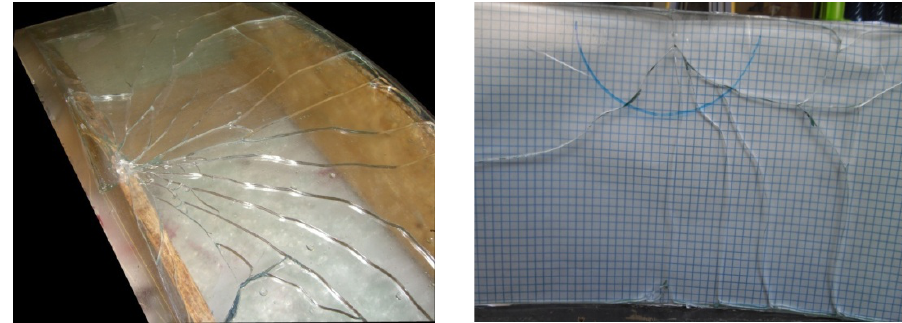
Figure 7a and b: Breakage pattern of curved heat strengthened glass panels (7a: not conform, 7b: conform to DIN EN 1863).